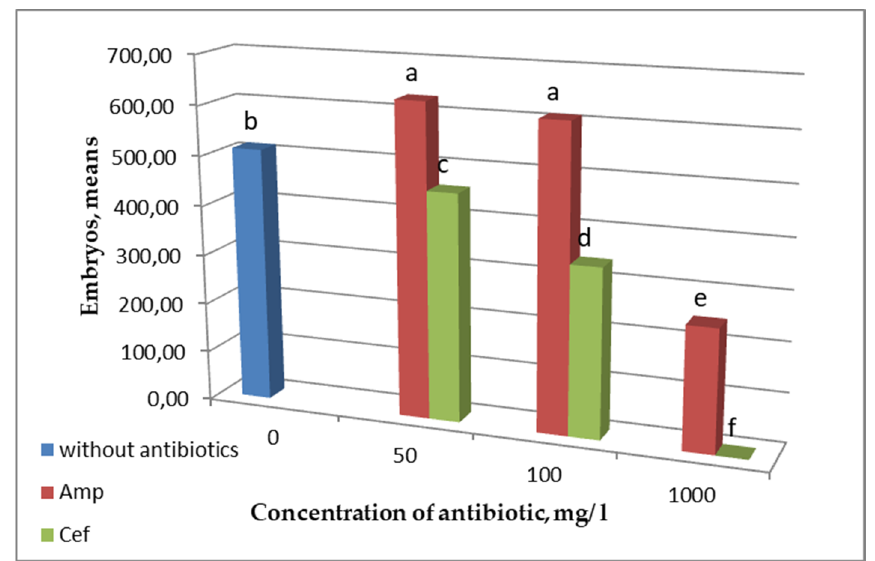
Figure 5. Effect of antibiotic type and concentration on B. napus embryo yield. Values marked with similar letters had no significant differences at p ≤ 0.05.